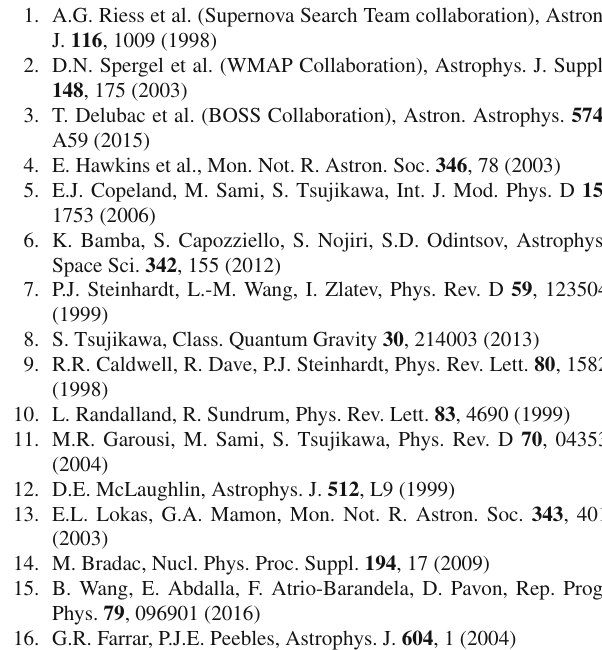
model ( β (cid:6)= 0, solid red line), minimally coupled Slotheon dark energy model ( β = 0, dashed purple line) and coupled Slotheon dark energy model ( β (cid:6)= 0, dashed blue